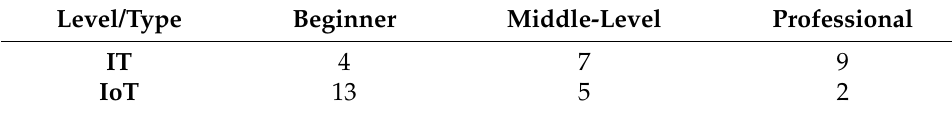
Table 2. Level of knowledge of the users in IT and the